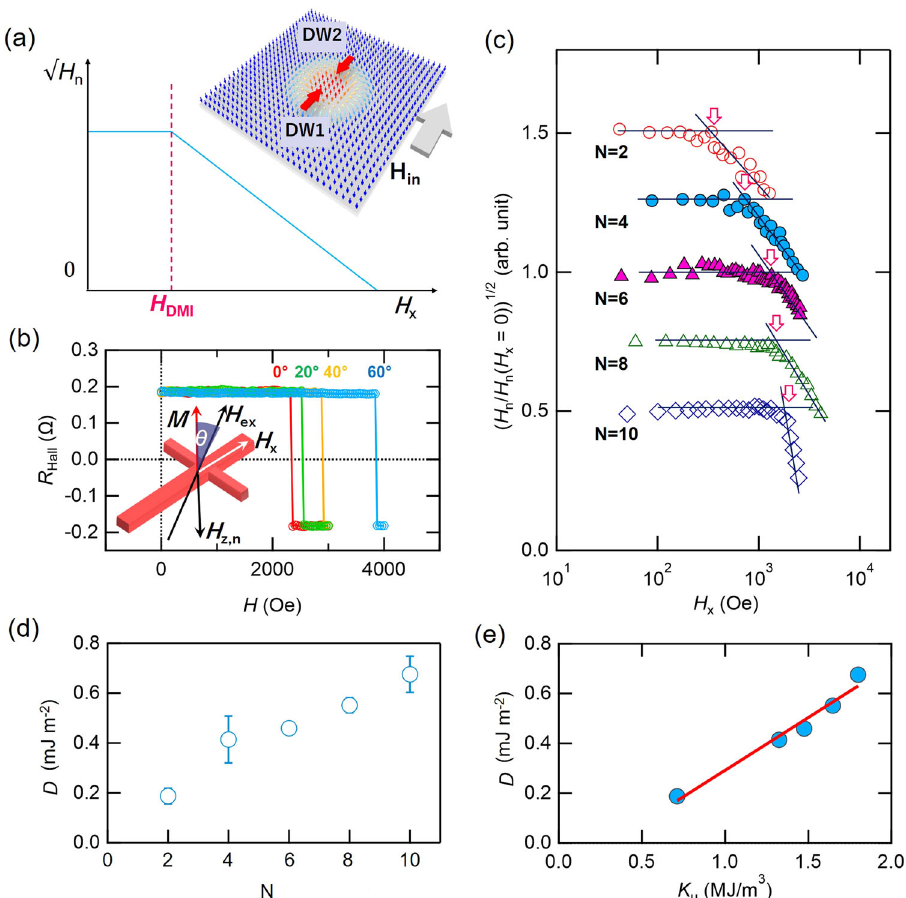
Fig. 6 N-dependent DMI of the [Co/Pd/Pt]-SL. a Illustration of droplet nucleation fi eld pro fi le in terms of in-plane fi eld. b H SW of the [Co/Pd/ Pt]-SL with N = 6 measured using anomalous Hall effect in terms of θ . Inset shows the con fi guration of a device with external fi eld ( H ex ), components of the H ex ( H x and H z ), and M s . Solid lines are the fi tting results before and after the threshold fi eld. c Normalized plots in terms of N. The solid lines indicate the fi tted lines when H x < H DMI and H X > H DMI . H DMI values can be obtained from crossing points indicated by the arrows. d D values of the SLs in terms of N. e K u vs. D plots. The red solid line is the linearly fi tted line. The error bars represent standard deviations from the best fi